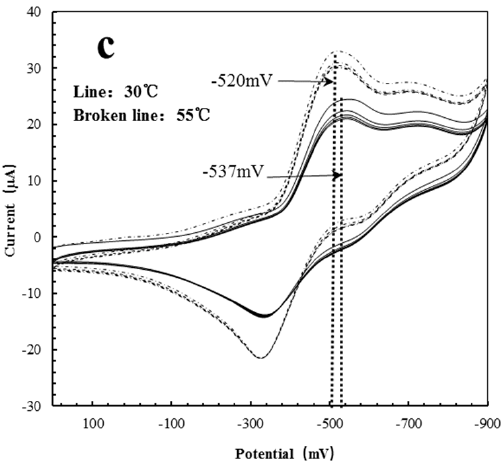
Figure 9. Reduction profiles with MB desorbing from the prepared polymer reactors (( a ) AgHBP-A; ( b ) HBP-A; ( c ) AgHBP-N).